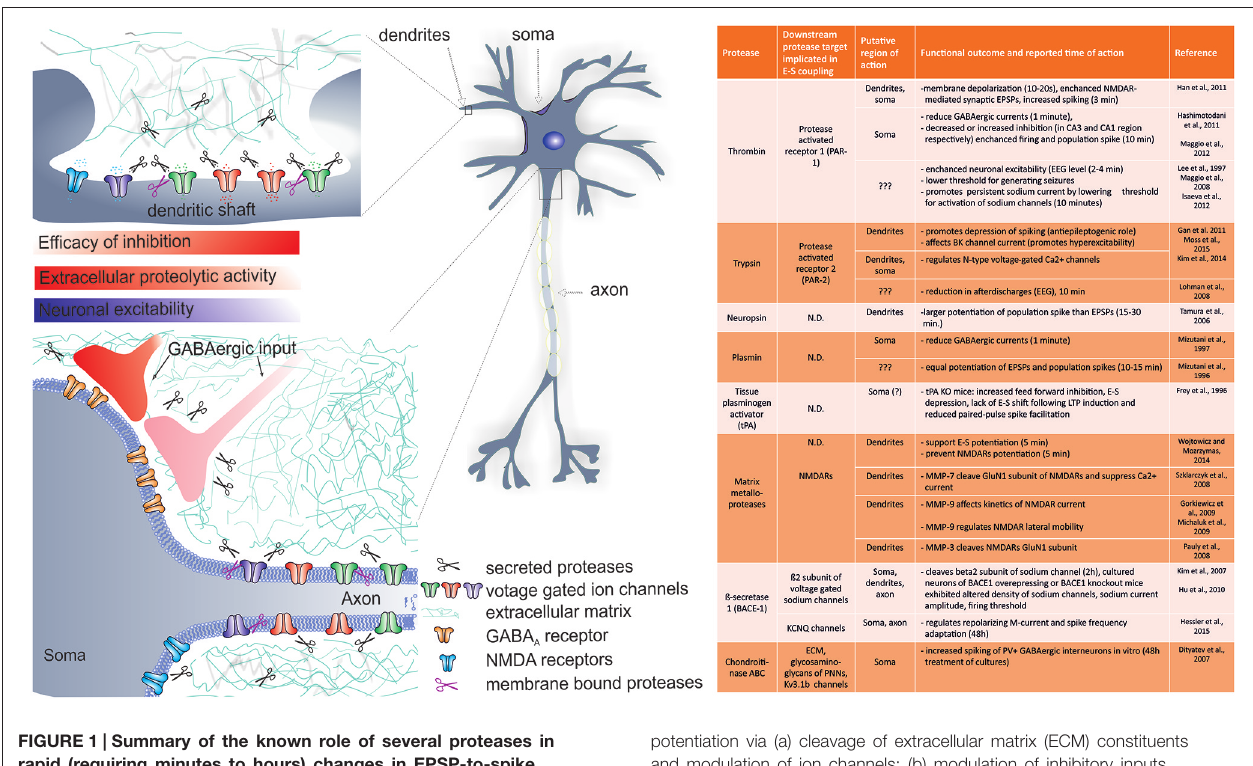
FIGURE 1 | Summary of the known role of several proteases in rapid (requiring minutes to hours) changes in EPSP-to-spike (E-S) potentiation and/or neuronal spiking. A cartoon indicates the putative regions of CA1 pyramidal neuron where extracellular proteolysis may affect intrinsic neuronal excitability and E-S